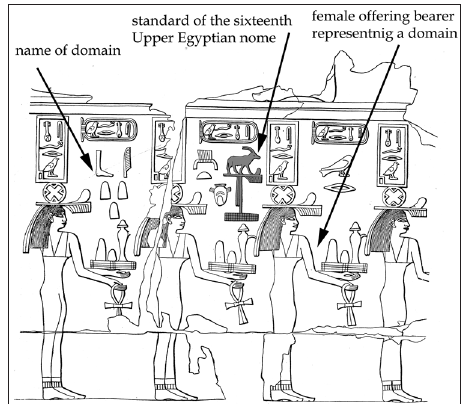
Fig. 3: Blocks from valley temple of Sneferu at Dahshur. According to the hieroglyphs on their head, the female offering bear- ers represent ‘domains of Sneferu’. The names of the domains are written in front of them, here ‘Great is Sneferu’, ‘Joy of Sneferu’, and ‘Gaming pieces of Sneferu’. The domains are grouped according to their location in nomes, here the six- teenth nome of Upper Egypt shaded grey. Architecturally, the figures were originally oriented towards the statue of the king. (After Fakhry, 1961: Fig.